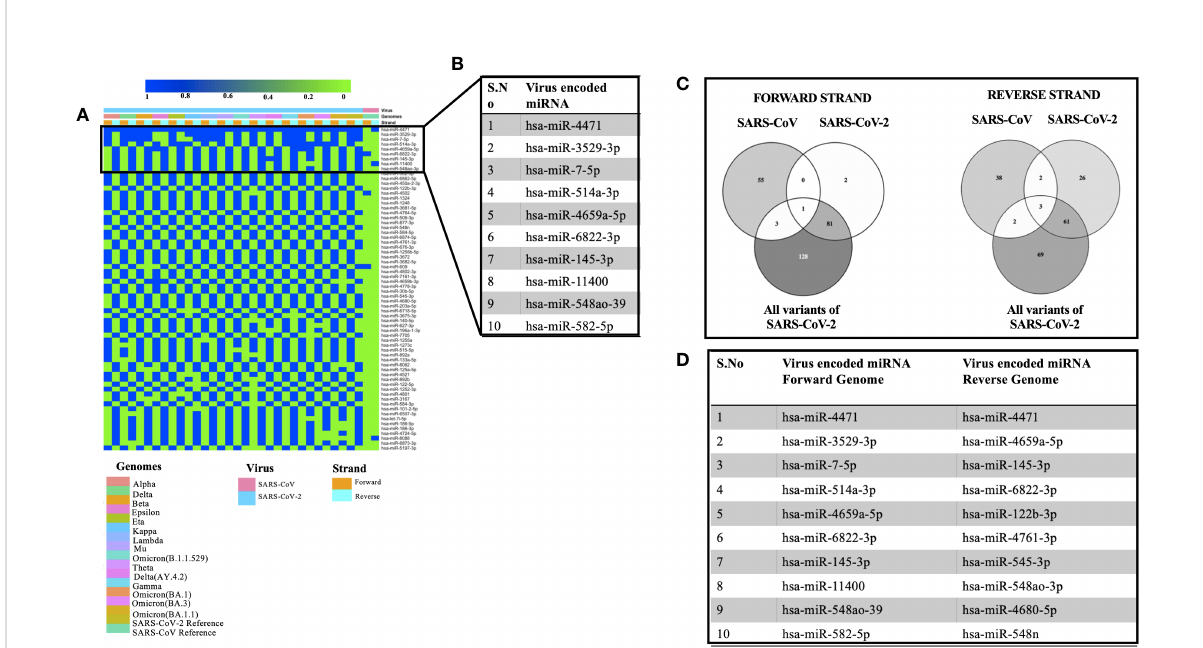
FIGURE 2 Showing the viral encoded miRNAs that had similarity with that of miRNAs encoded by the H sapiens. (A) Heatmap showing miRNAs encoded by 45% of the genomes under study. (B) Top 10 miRNAs that could target various genomes used in the study. (C) Common miRNAs among the forward and the reverse genomic sequences of SARS, SARS-CoV-2 and its variants. (D) Top 10 miRNAs targeting forward and the reverse genomes used in the